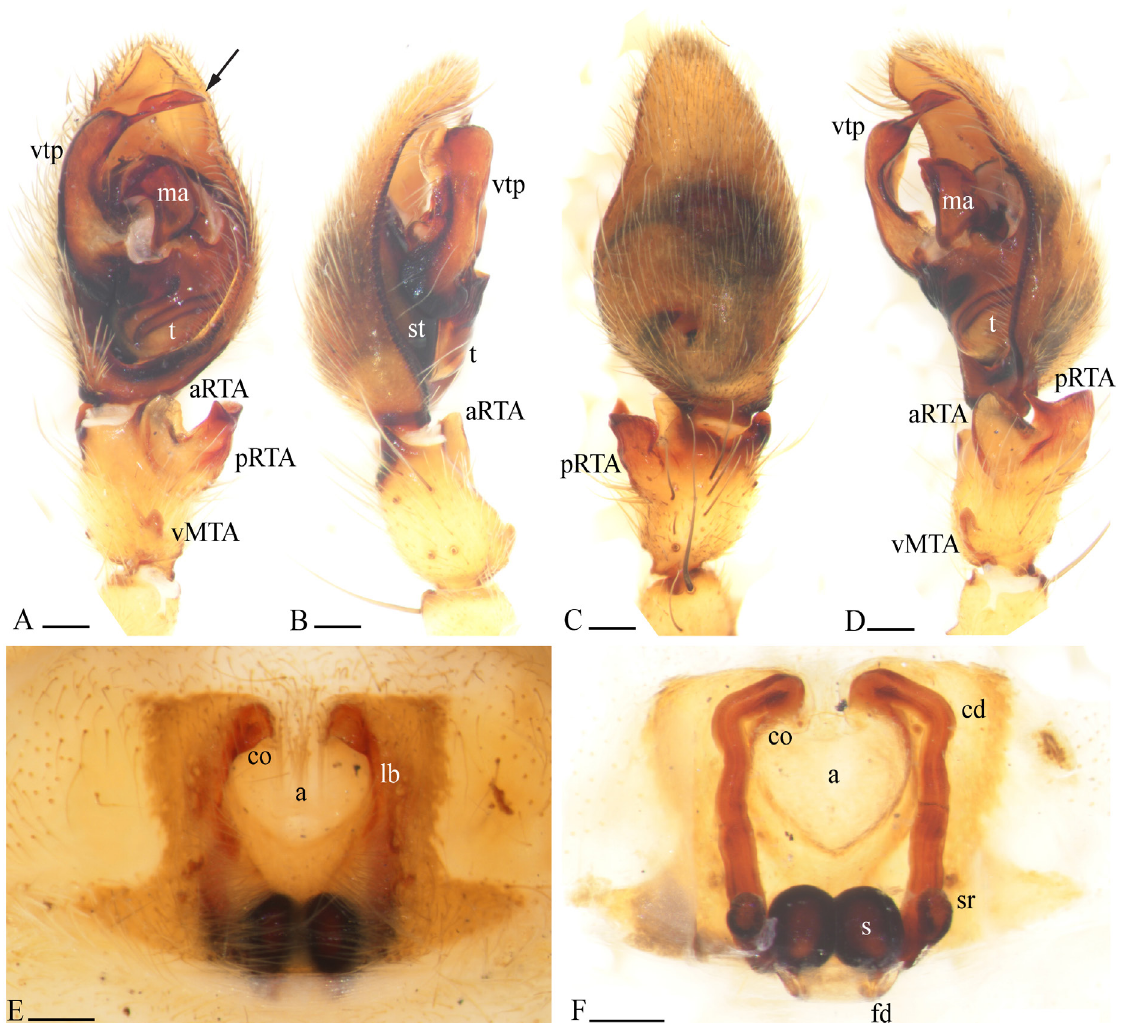
Fig. 23. Anyphaena epicardia sp. nov. A–D . Paratype, ♂ (CNAN-T01556). E–F . Holotype, ♀ (CNAN-T01557). A . Pedipalp, ventral view. B . Pedipalp, prolateral view. C . Pedipalp, dorsal view. D . Pedipalp, retrolateral view. E . Epigynum, ventral view. F . Epigynum, dorsal view. Scale bars: 0.2